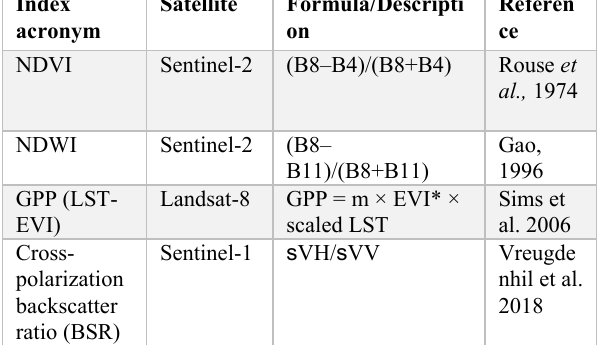
CCE data points were overlaid on Sentinel 2 (20m pixel) datasets and a square buffer of 3 X 3 were created around each location and each pixel were assigned the same yield. Hence a total of 178*9 = 1602 pixels information was used in further analysis.